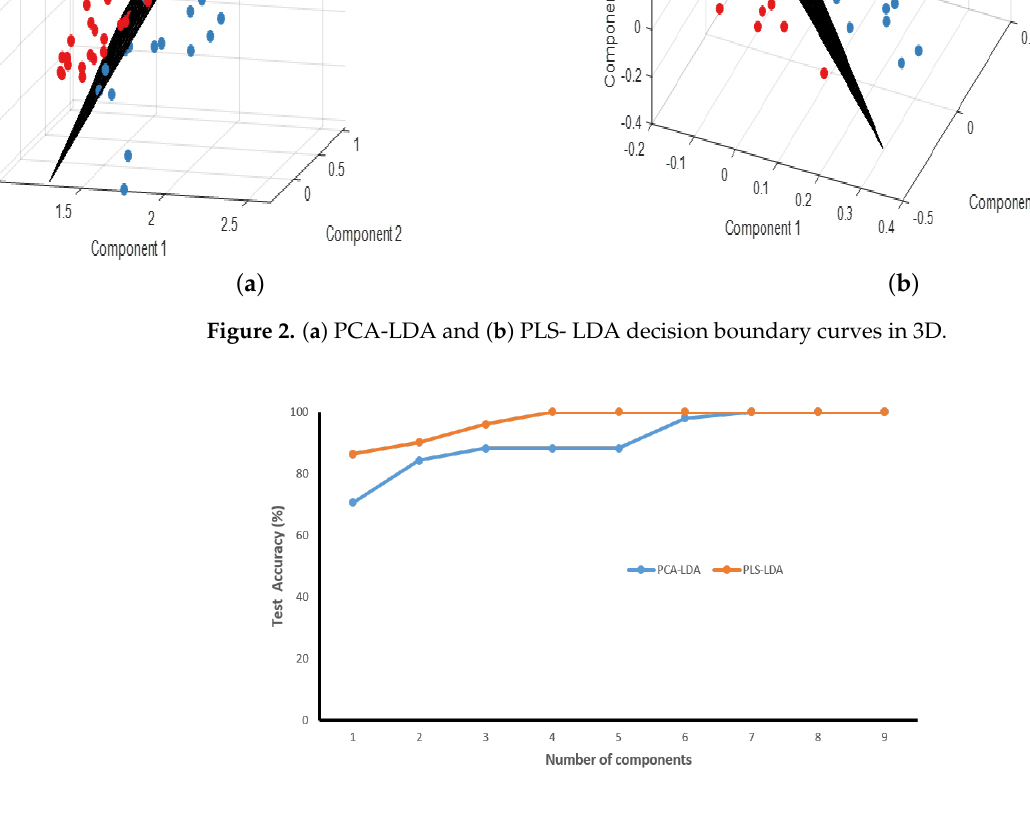
Figure 3. Accuracy rates versus number of components on PCA-LDA and PLS-LDA in the oral cancer